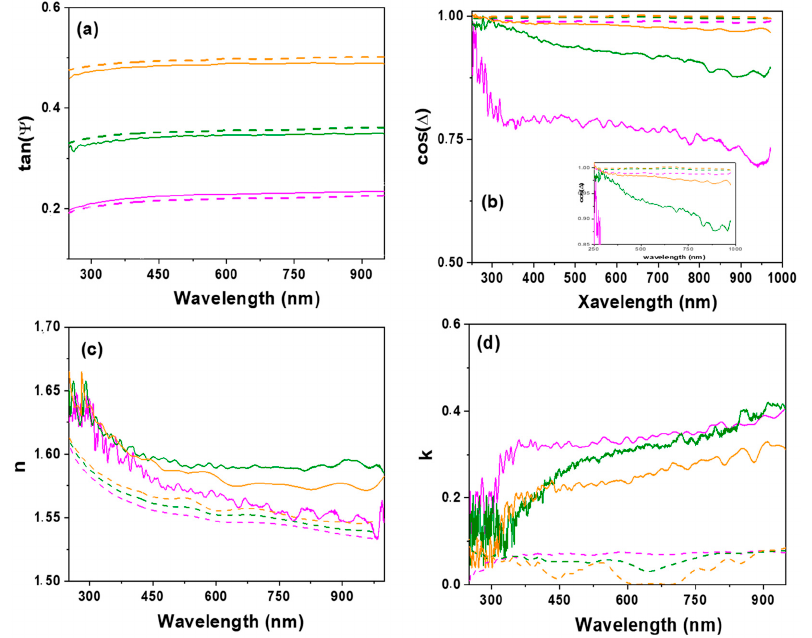
Figure 8. Wavelength dependence of: ( a ) tan ( Ψ ); ( b ) cos( Δ ); ( c ) refraction index; ( d ) extinction coef- ficient, for the RC-4 support (dashed lines) and the RC-4/CdSe-QDs@S-DAB 5 film (solid lines) de- termined at different light incident angles: 65° (magenta line), 70° (green line) and 75° (orange line). As it can be observed in Figure 8c rather similar values for both refraction index and extinction coefficient were obtained at the different light incident angles for the RC-4 sup- port, which is an indication of film smooth surface and homogeneity, and the small dif- ferences are attributed to surface impurities associated to environmental contamination; the following average values were determined: <n> = 1.56 ± 0.03 and <k> = 0.06 ± 0.03, which do not differ significantly from those reported for regenerated cellulose (1.48) and other polymers (between 1.53 and 1.58) measured at a unique wavelength of 589 nm [60], and zero in the case of extinction coefficient (no light absorption). However, higher values variability depending on the light incident angle was obtained for the RC-4/CdSe-QDs@S- DAB 5 film, which is attributed to sample inhomogeneity caused by inclusion of the CdSe- QDs@S-DAB 5 nanoparticles, as well as the surface roughness associated to CdSe QDs presence already established by SEM images. The following average values for the refrac- tion index were estimated: <n(65°)> = 1.58 ± 0.05, <n(70°)> = 1.62 ± 0.03 and <n(75°)> = 1.59 ± 0.03; in the case of the extinction coefficient: <k(65°)> = 0.32 ± 0.03, <k(70°)> = 0.27 ± 0.09 and <k(75°)> = 0.22 ± 0.11, indicating higher light absorption by the modified film. Conse- quently, the increase of n and k values determined for the RC-4/CdSe-QDs@S-DAB 5 film with respect to the RC-4 support is an indication of CdSe QDs contribution in the optical behavior of the modified film (reported values for CdSe refractive index range between 2.35 and 2.64 [61]). The effect of the type of QDs (bare silicon dots, carbon dots, or nitrogen-doped car- bon dots) on optical characteristics of the RC-QDs modified films was already studied in a previous paper [28] by comparing wavelength dependence of n and k parameters, and differences in both curve shape and values depending on the selected QDs nanoparticles were obtained. Therefore, the effect on optical parameters associated with dendrimers